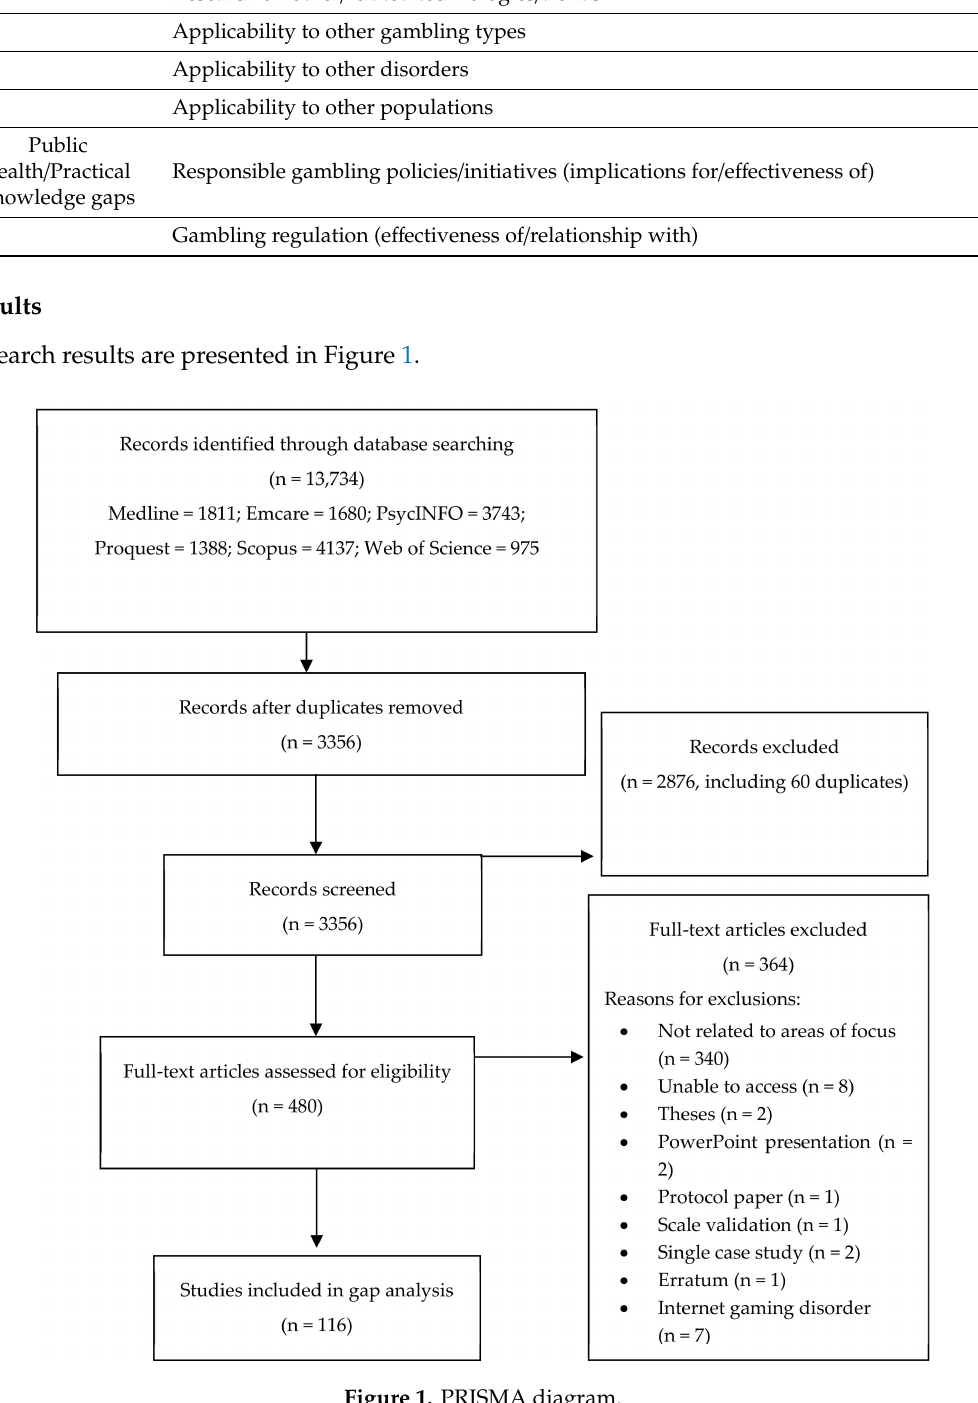
Figure 1. PRISMA